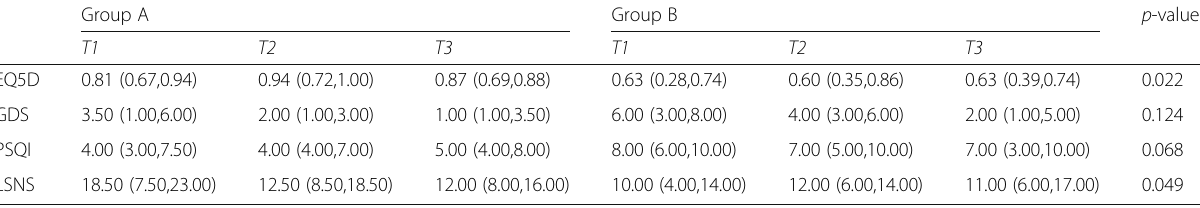
Table 2 Median values of EQ5D, GDS, PSQI and LSNS at the different data collection points Group A Group